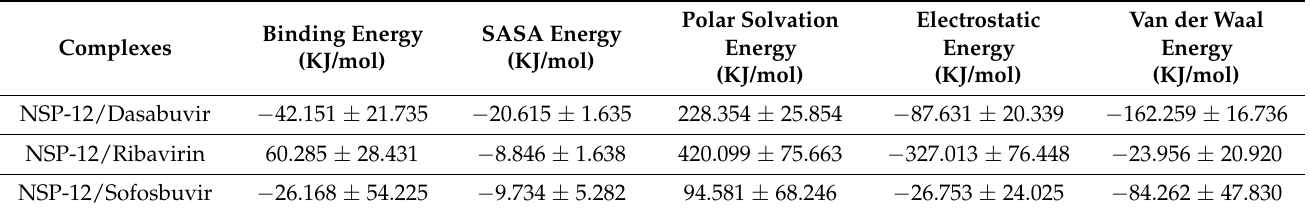
Table 1. List of observed average and standard deviations of all energetic components including the binding energy taken from MM-PBSA